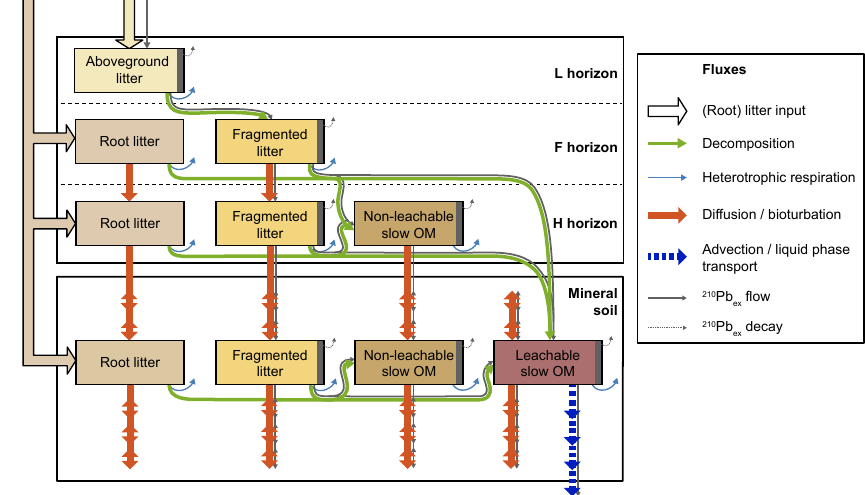
Fig. 1. Overview of the SOMPROF model and the 210 Pb ex module. The dark gray rectangles indicate 210 Pb ex associated with the organic matter